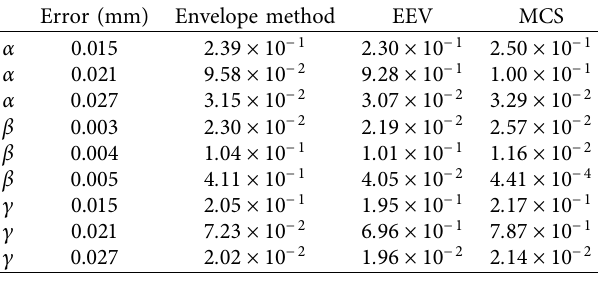
Table 4: Reliability of attitude.